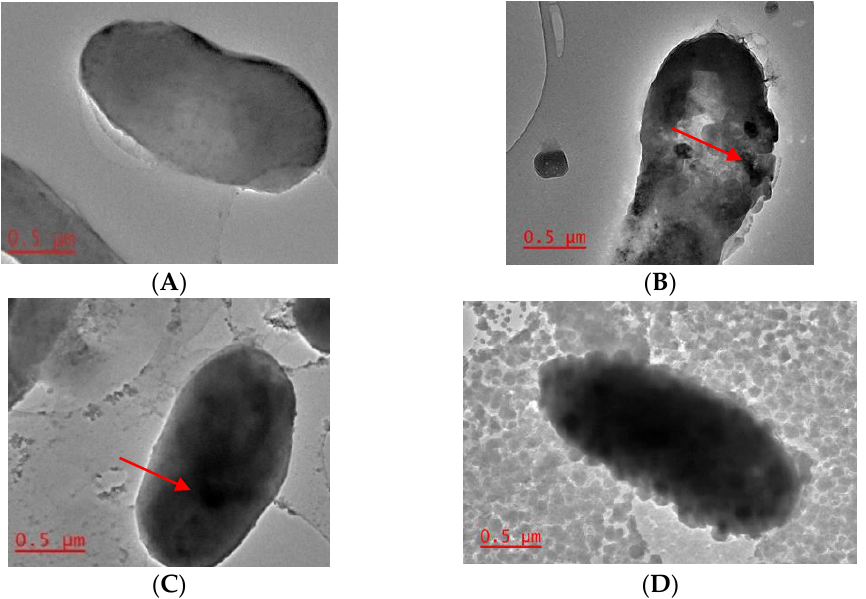
Figure 1. Transmission electron micrographs of M. radiotolerans MAMP 4754 after 2 days of inocu- lation. ( A ): Untreated cell; ( B ): Nickel-treated cells (12 mM); ( C ): Copper-treated cells (4 mM); ( D ): Zinc-treated cells (15 mM). The arrows indicate metal accumulation/aggregation within the cell. Table 4. Gas chromatography high-resolution time-of-flight mass spectrometry (GC-HRTOFMS) analysis of the crude extract of M. radiotolerans MAMP 4754, showing microbial compounds reported for their ability to promote plant growth. R.T